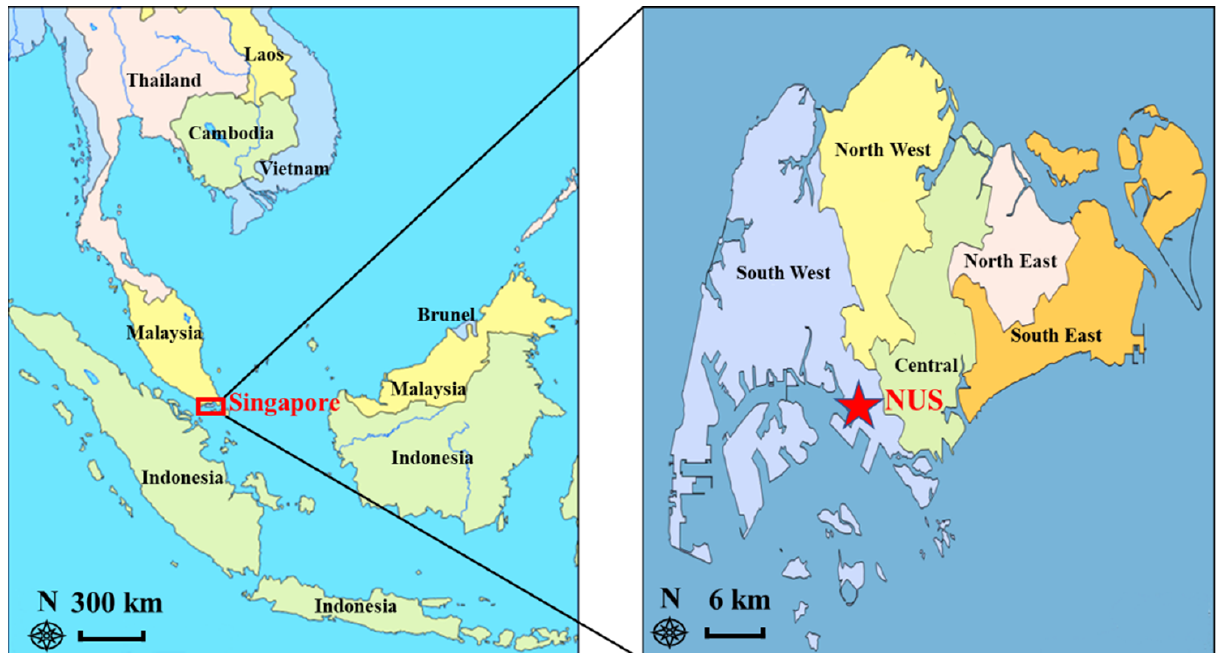
Figure 1. The location of the sampling site (the original image comes from the open-source website: https://d-maps.com/index.php?lang=en, accessed on 17 July 2022).